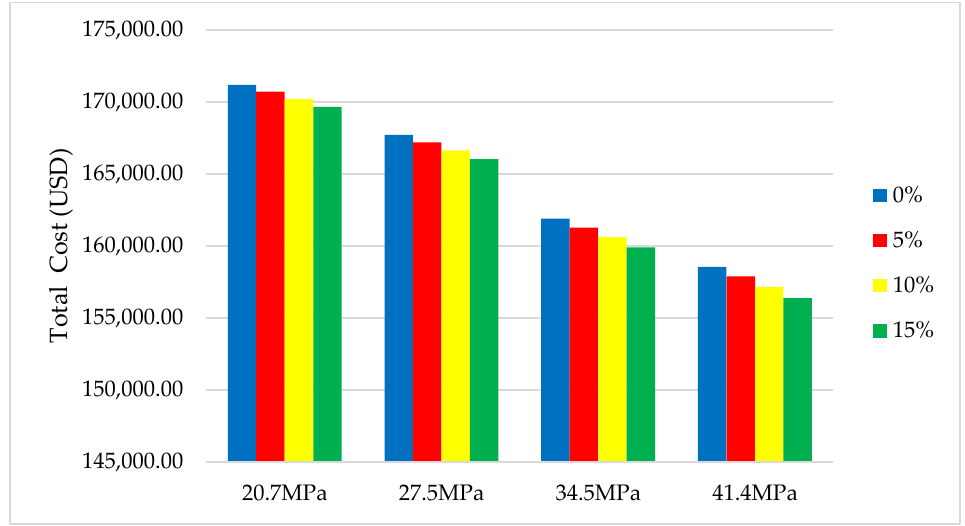
Figure 6. Seven-story total cost with different concrete design strengths with CS as SCM.